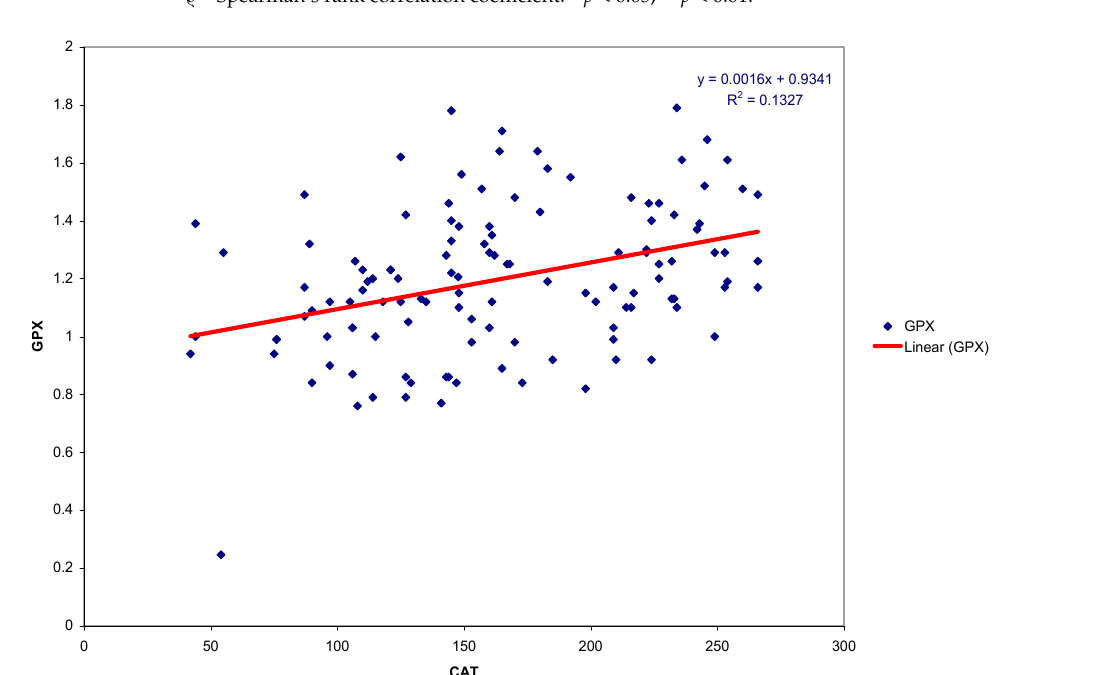
Figure 1. Scatter plot and regression line of GPX and CAT activities in the group of subjects with gingivitis.